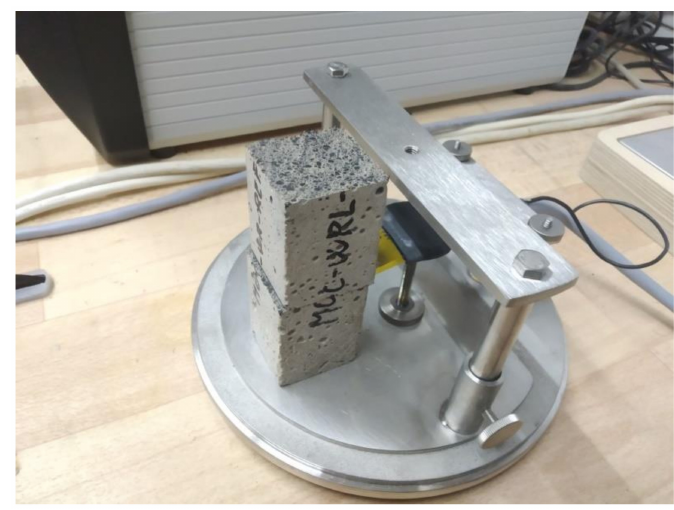
Figure 4. Experimental setup for thermophysical parameter measurement.